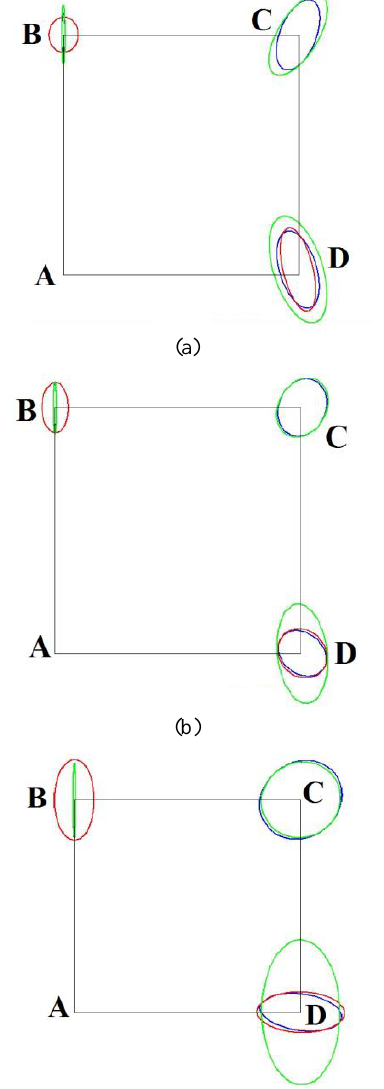
Figure 6. Error ellipses for results obtained from three adjustment methods of Transit (shown in green), Bowditch (shown in red) and the Least Squares (shown in blue) for simulated data for a regular hexagonal grid with side lengths of one kilometer. In case a, an observation error of 5cm for the lengths and 40s for the angles, in case b, an observation error of 10cm for the lengths and 20s for the angles, and in case c, an observation error of 20cm for the lengths and 10s for the angles was considered. Error ellipses are magnified by 1000